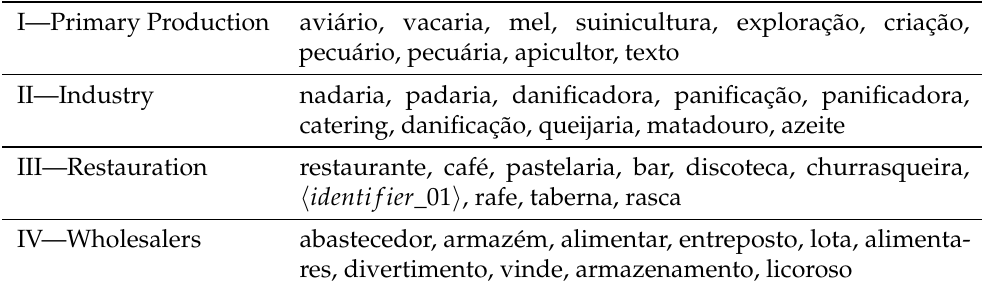
Table 15. Top-10 features for economic activity prediction using spell checking with